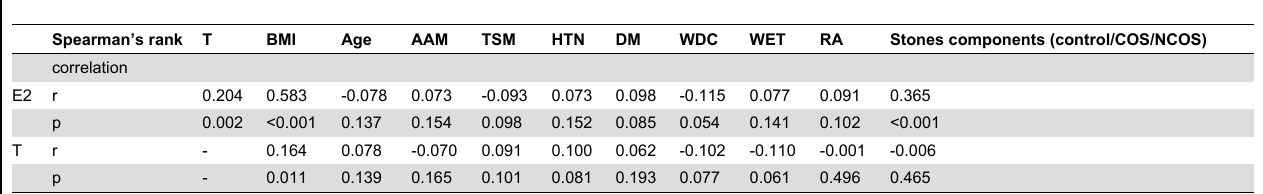
Table 2. Spearman’s correlation using estradiol (E2) and testosterone (T) as dependent variables in all 197 subjects.